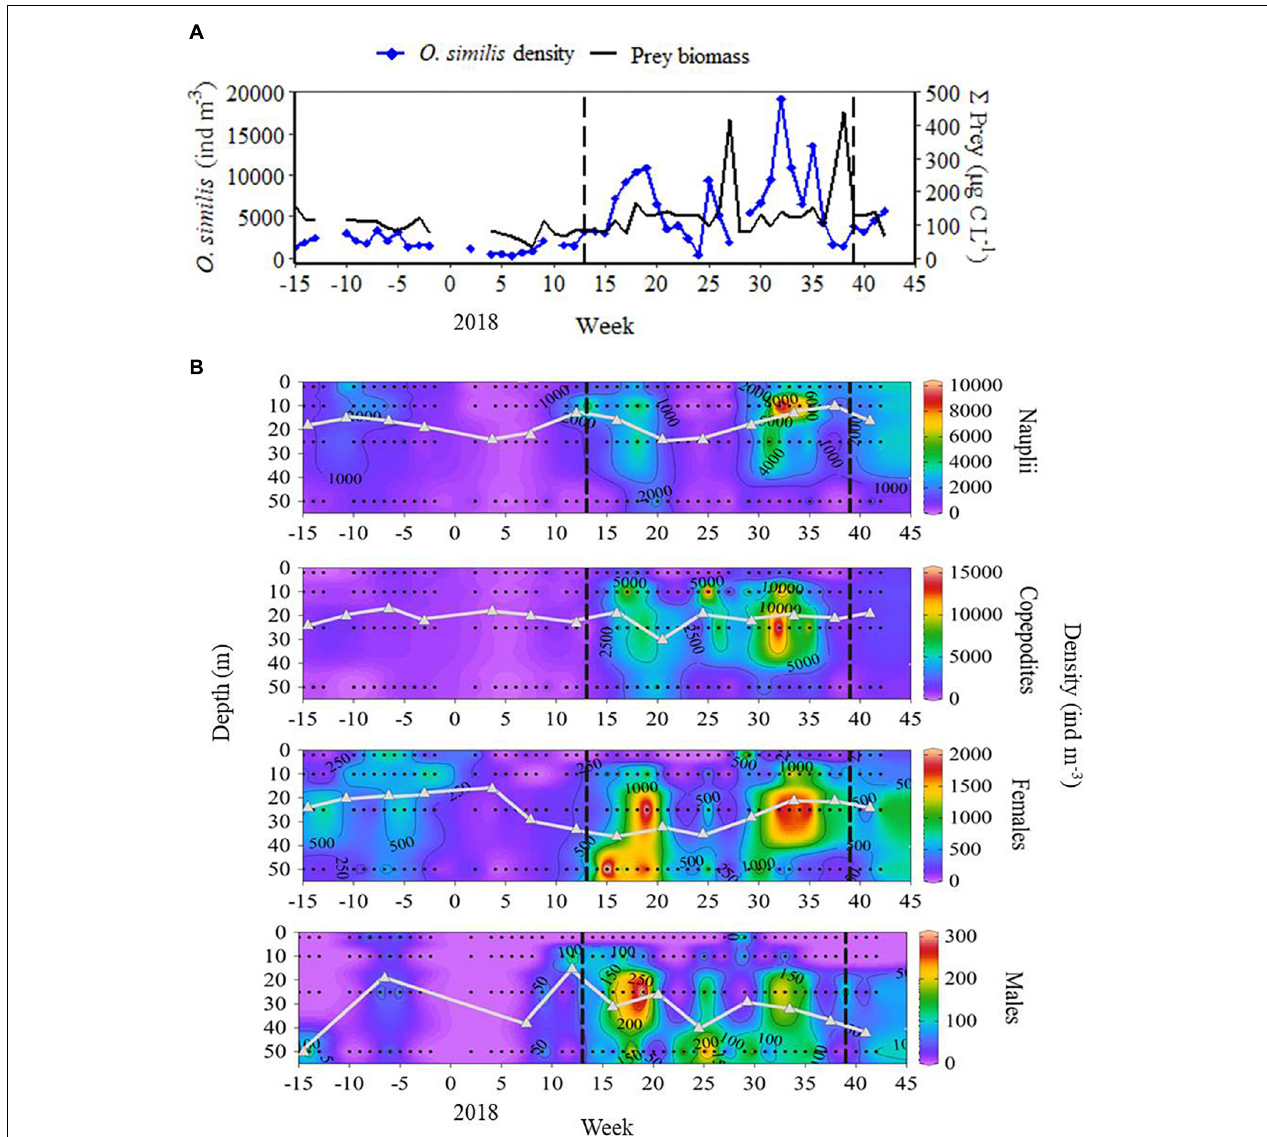
FIGURE 5 | (A) Depth-integrated O. similis population density including all life stages, against total prey biomass, excluding bacteria, over the 2017–2018 study; (B) O. similis nauplii, copepodite, adult female, and adult male density over the 2017–2018 study (Ocean Data View, Schlitzer, 2018). Grey triangles represent weighted mean depth (WMD). Vertical dashed lines mark the onset and breakdown of stratification, indicated by the switch in surface NHF from negative to positive (week 13), and positive to negative (week 39) during the 2017–2018